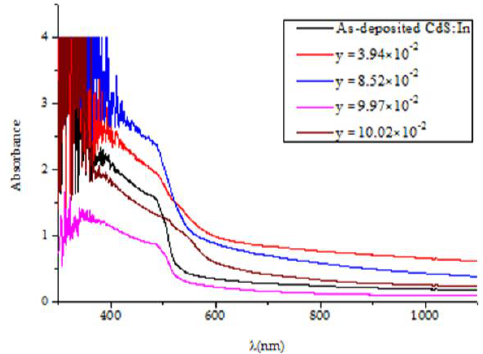
Figure 6. The absorbance of CdS 1−y Te y thin films of different composition and comparable thickness besides that of a CdS:In film.